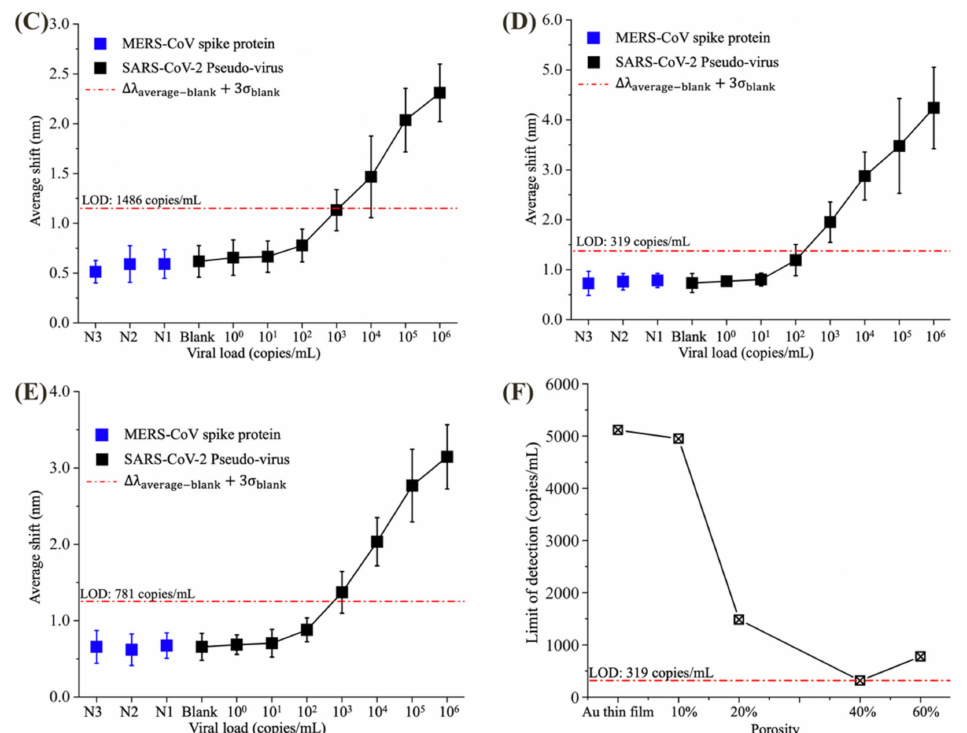
Figure 6. Detection performance of ( A ) Au thin film, ( B ) 10%, ( C ) 20%, ( D ) 40%, and ( E ) 60% porosity